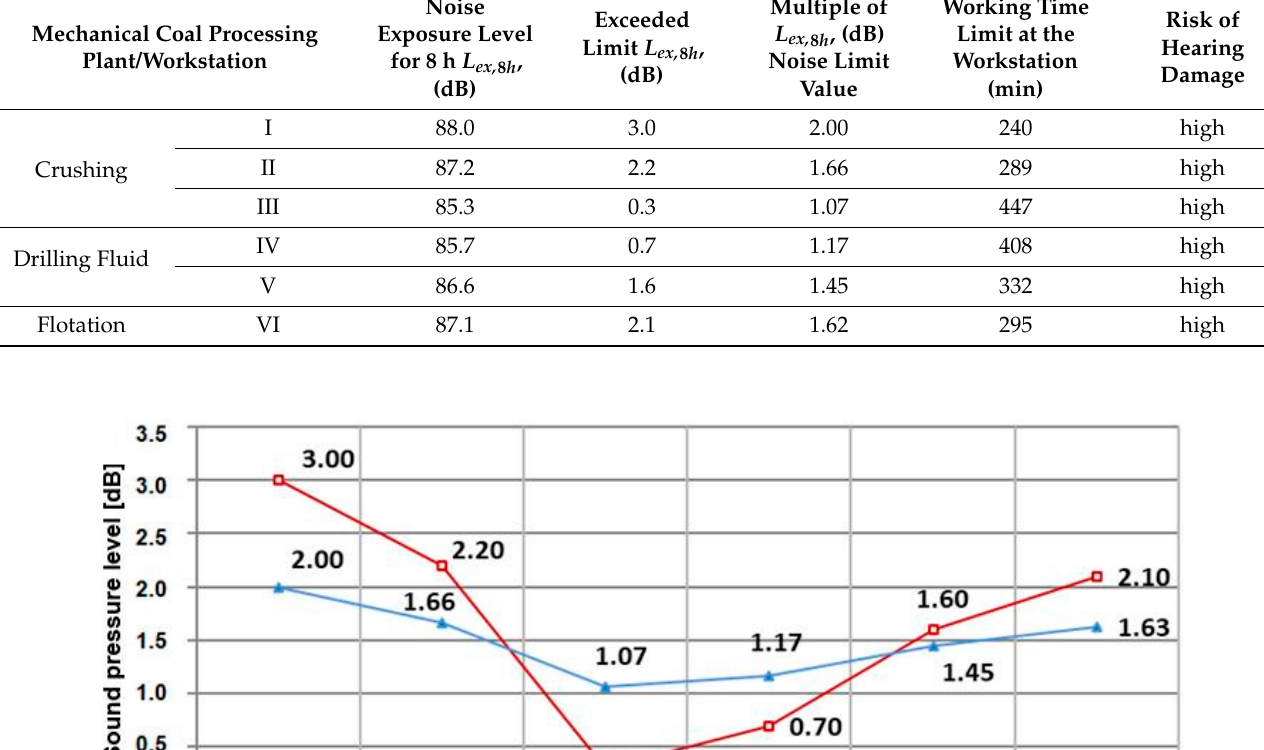
Table 4. Noise analysis at individual workstations of the mechanical coal processing plant.